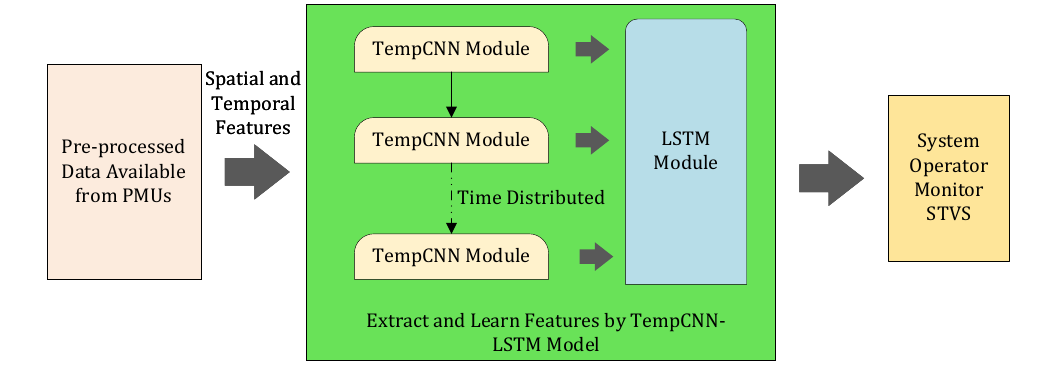
Figure 5. Framework of proposed TempCNN-LSTM